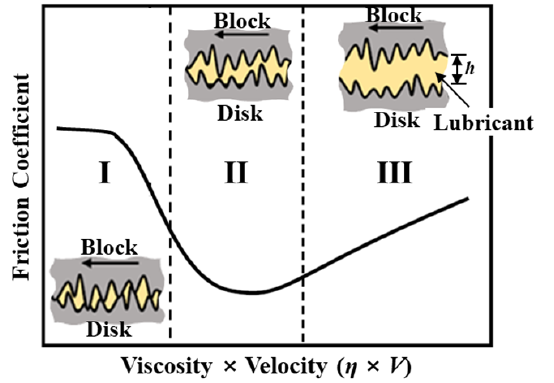
Figure 8. Schematic of the Stribeck curve showing three typical lubrication regimes. As shown in Figure 3, unlike the dry contact, W s decrease under the water-lubricated contact at 300 rpm. This may be attributed to the change in the lubrication regime